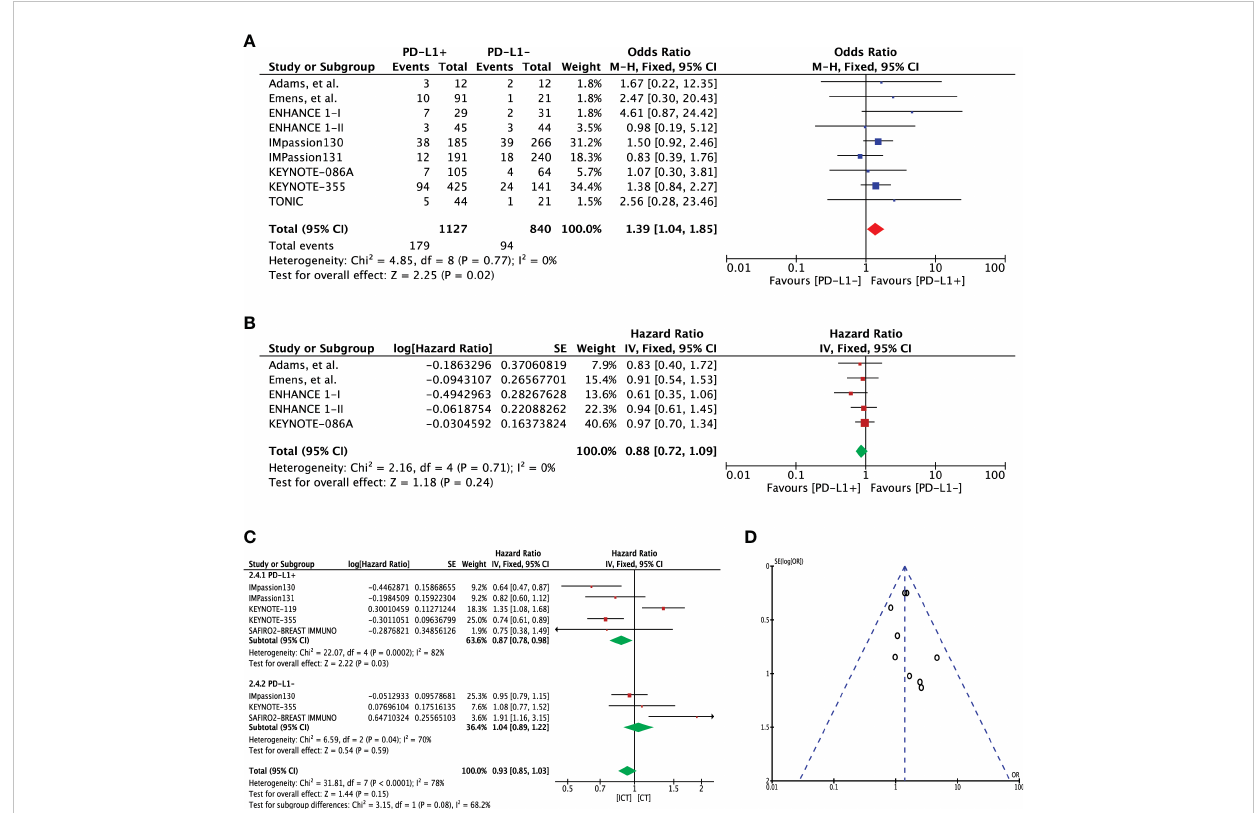
FIGURE 3 (A) Comparison of 1-year progression-free survival (PFS) in advanced metastatic TNBC (mTNBC) patients treated with PD-1 checkpoint inhibition therapy based on PD-L1 expression. (B) Comparison of progression-free survival (PFS) in advanced metastatic TNBC (mTNBC) patients treated with PD-1 checkpoint inhibition therapy based on PD-L1 expression. (C) Comparison of progression-free survival (PFS) in PD-L1+ and PD-L1- metastatic TNBC (mTNBC) patients between patients receiving PD-1 checkpoint inhibitors plus chemotherapy (ICT) and CT alone. (D) Funnel plot of publication bias assessment in 1-year progression-free survival (PFS)